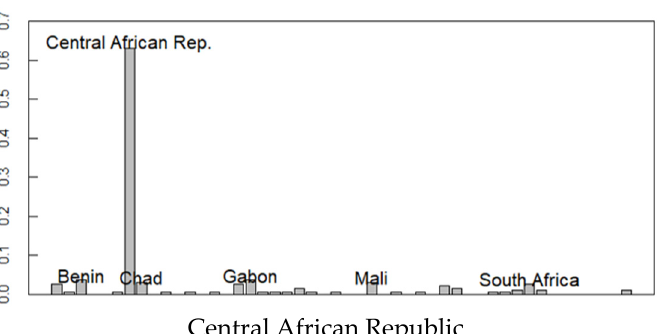
Figure 7. Network clustered by similarity of ethnic composition.